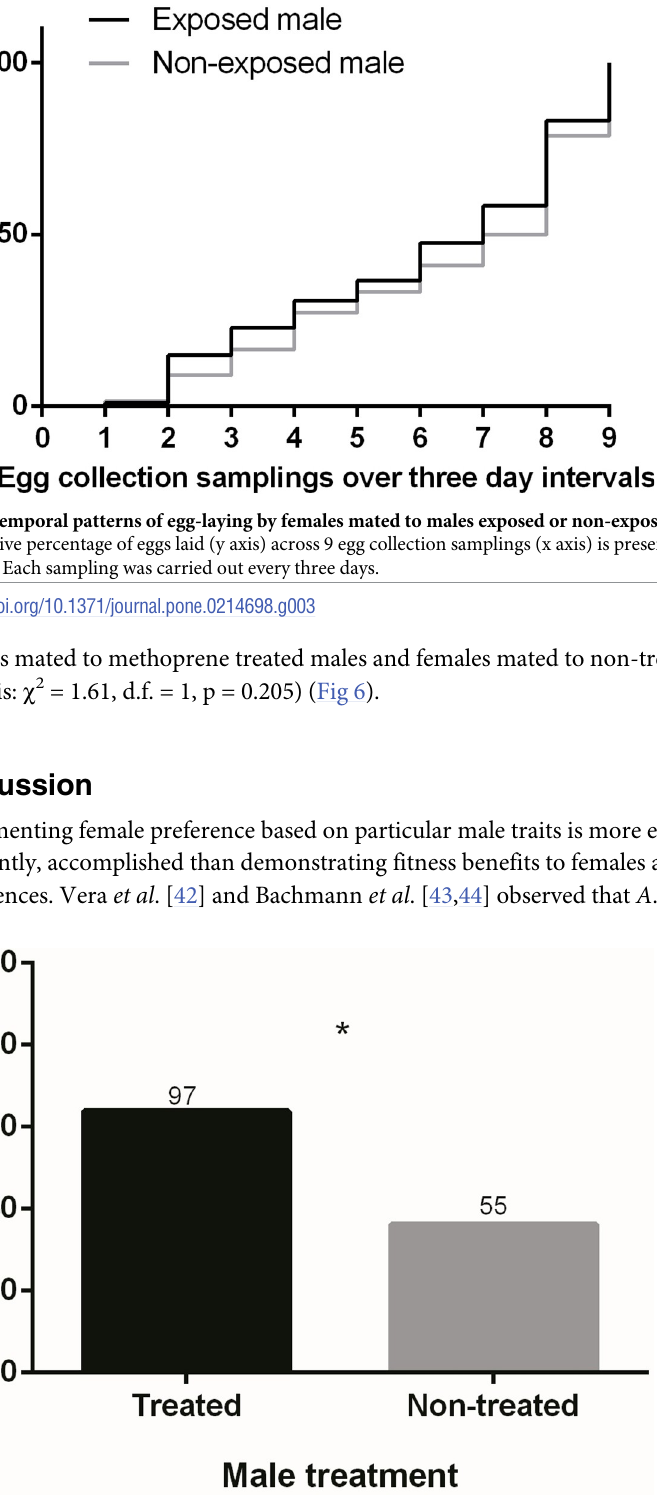
Fig 4. Percentage of matings obtained by males treated or non-treated with methoprene. Numbers above bars represent numbers of matings. � statistically significant difference ( α = 0.05).